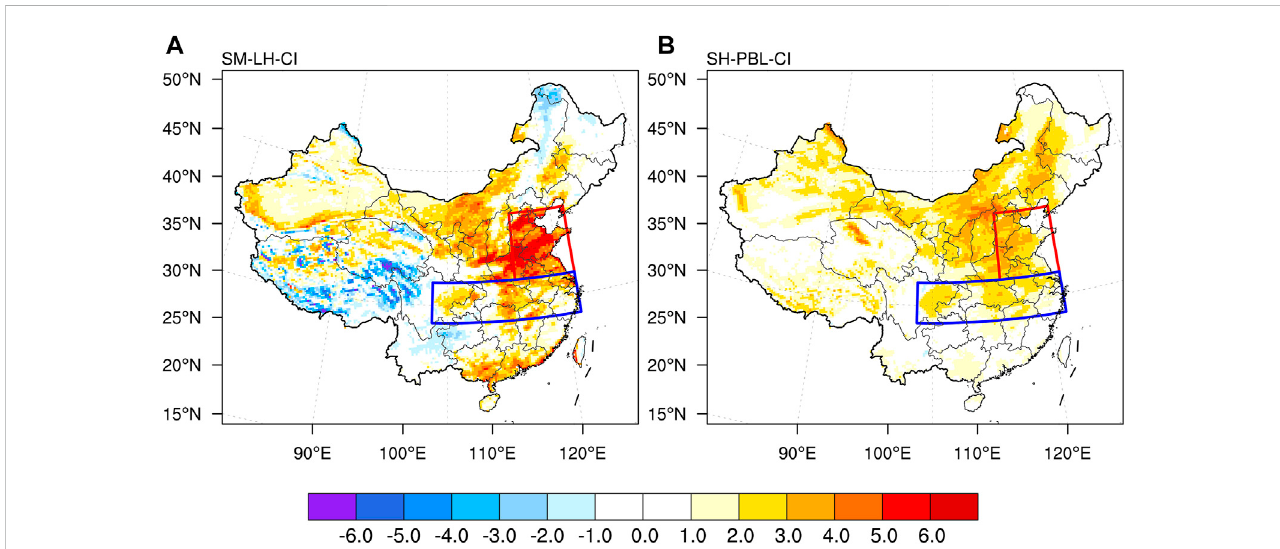
FIGURE 9 The climatology features of land-atmosphere coupling strength in the CTL experiment calculated using the “ two legged ” land-atmosphere coupling metric: (A) terrestrial coupling indices (i.e., the coupling between soil moisture and latent heat), units: W m − 2 and (B) atmospheric coupling indices (i.e., the couplingbetweensensibleheatandplanetaryboundarylayerheight),units:10 1 W m − 2 .Notethattheredandblueboxesinthe fi gurerepresentNCP(32.5 – 40 ° N, 114 – 122 ° E) and YRB (28 – 32.5 ° N, 103 – 122 ° E) regions,